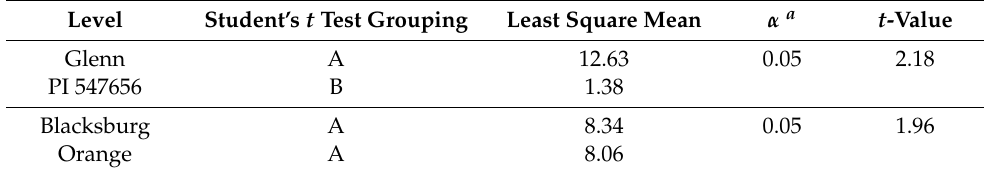
Table 2. Least squares mean differences using Student’s t test of Kunitz trypsin inhibitor concentration (KTI) between the two parents Glenn (normal KTI) and PI 547,656 (low KTI) planted in Blacksburg and Orange, VA in 2016 and 2017. Level